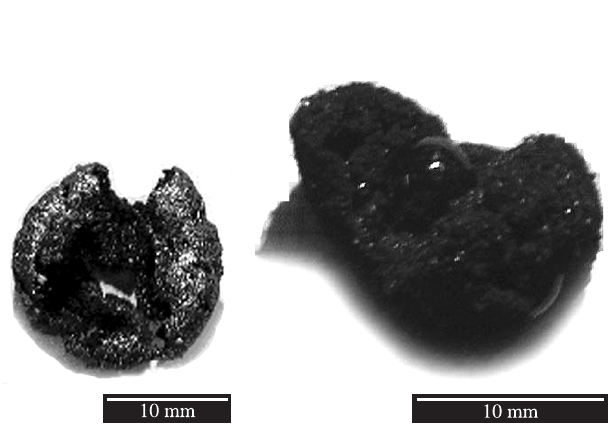
Figure 7. Iron ore-charcoal pellets after the experiments; left, no addition (high liquid temperature slag); right, addition of silica and alumina (low liquidus temperature